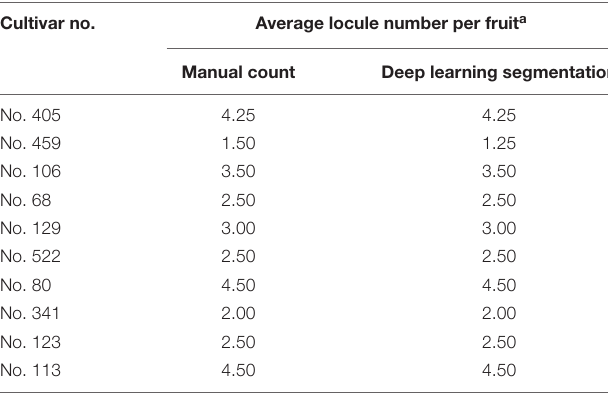
TABLE 2 | Tomato samples for image acquisition and phenotyping